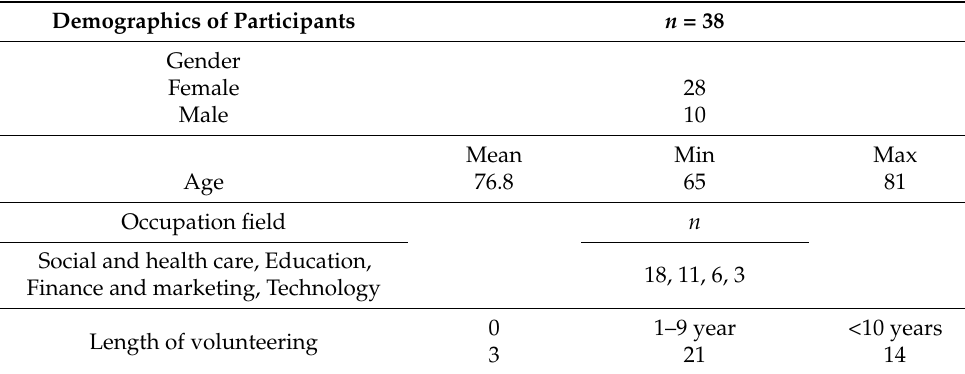
Table 1. Demographics of the study participants.